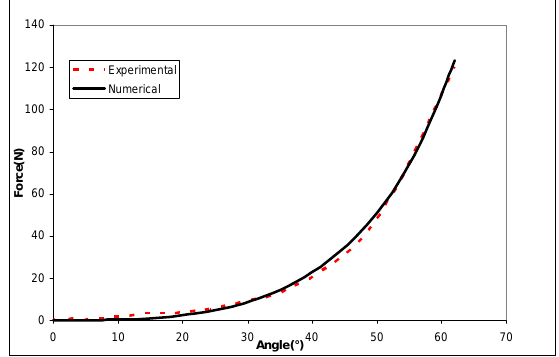
Fig 7: Tensile force vs shear angle